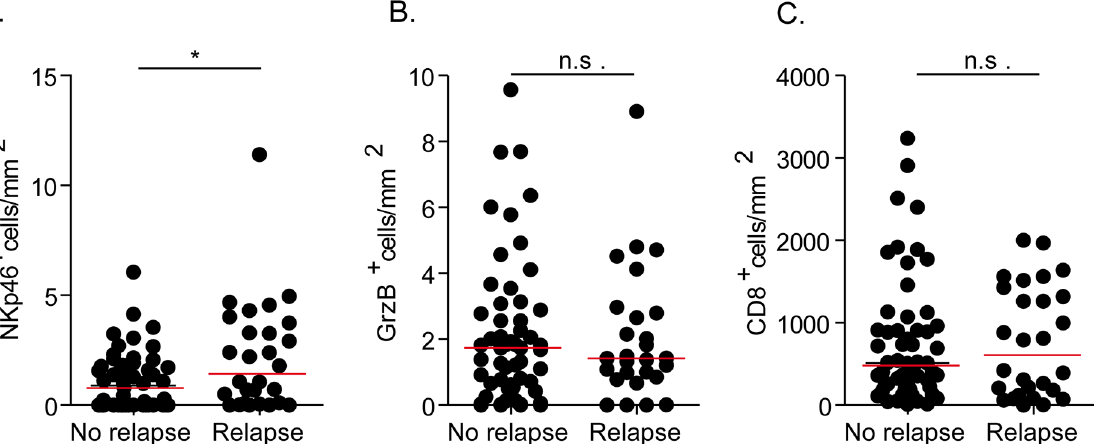
Fig 5. Association between numbers of cytotoxic (A) NK cells, (B) GrzB + cells, CD8 + T cells (C) and 5-year-relapse rate of the patients.